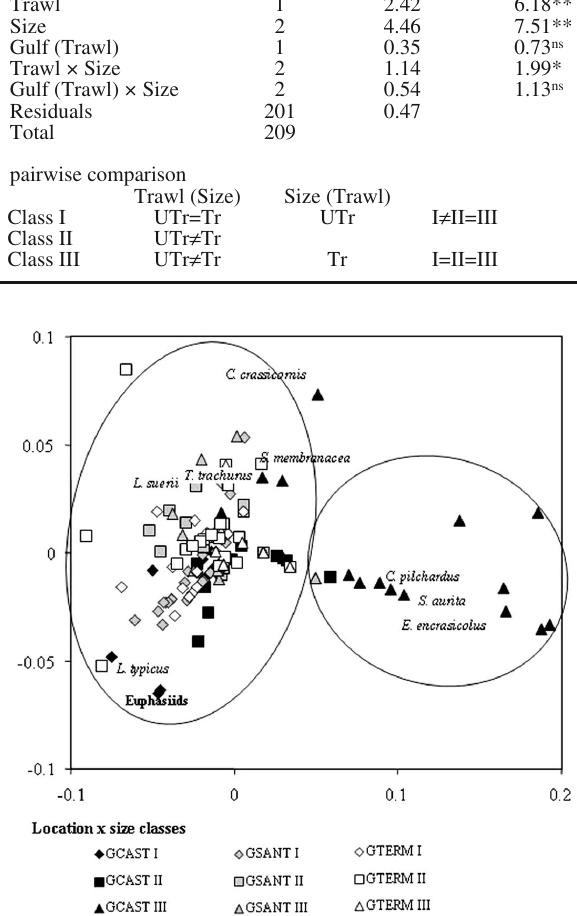
Fig. 4. – CCA (Correlative Correspondence Analysis) ordination performed on all stomach samples for the three gulfs and the three size classes. GCAST, Gulf of Castellammare; GTERM, Gulf of Termini Imerese; GSANT, Gulf of Sant’Agata; I, size class I